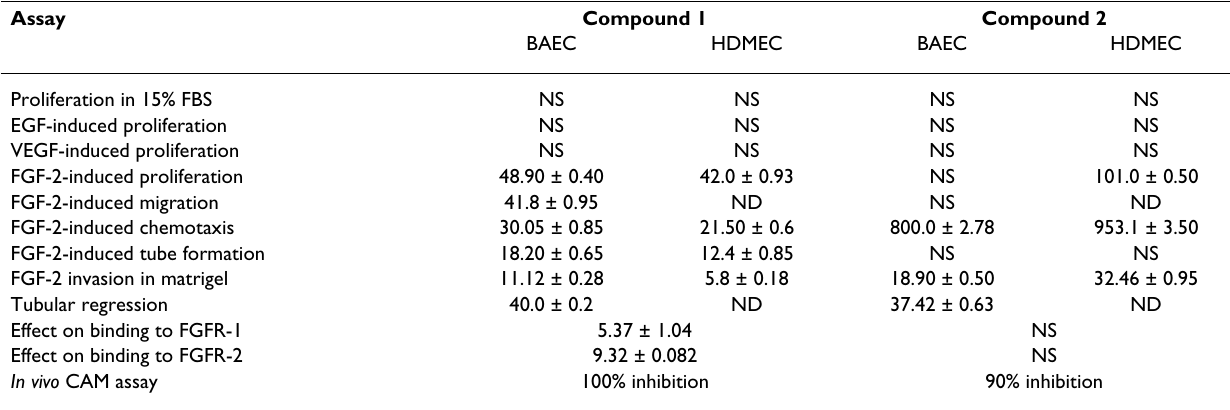
Table 1: A summary of the anti-angiogenic properties of stilbene glycosides.